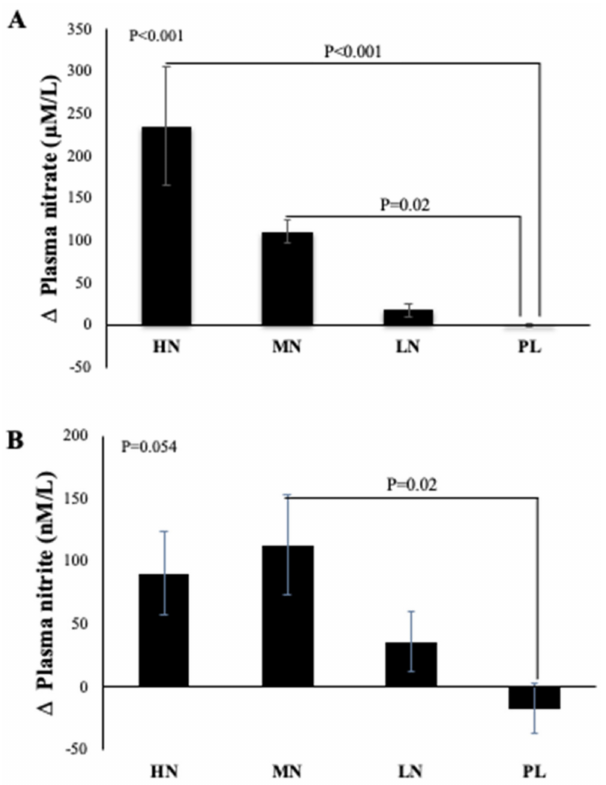
Figure 3. Mean changes in plasma NO 3 − ( A ) and NO 2 − ( B ) concentrations of incremental doses of dietary NO 3 − in form of BJ in older overweight and obese adults. HN (High NO 3 − ; two 70 mL shots of BJ/day, morning and evening), MN (Medium NO 3 − ; 70 mL of BJ/day), LN (Low NO 3 − ; 70 mL of BJ every alternate days) and PL (placebo; 70 mL of NO 3 − depleted BJ). Each shot of BJ contains 400 mg of NO 3 − . The change at 13-weeks from baseline data ( A , B ) were analysed with one-way ANOVA. Data are expressed as mean ± standard error of the mean (SEM) ( n = 49).